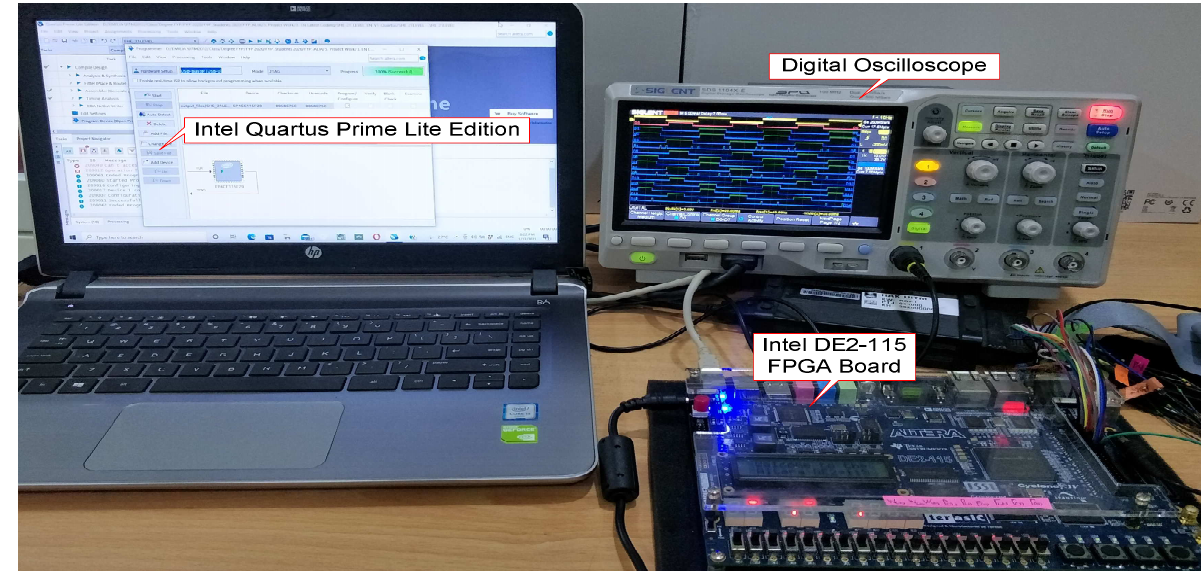
Figure 12. Hardware-measurement setup using an Intel field-programmable gate array (FPGA) (DE2-115) board and a digital oscilloscope.